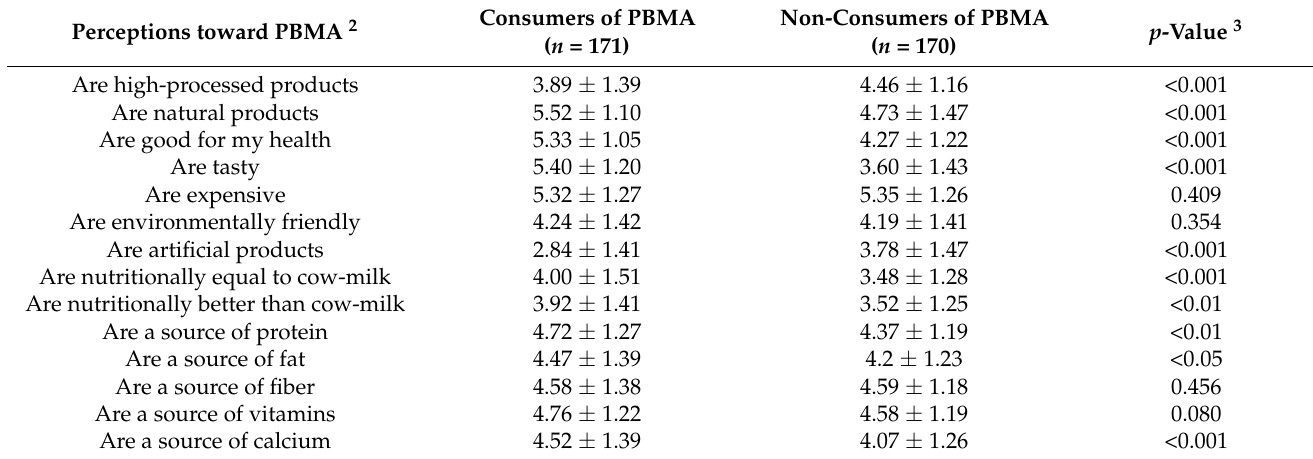
Table 3. Perceptions of consumers and non-consumers towards PBMA 1